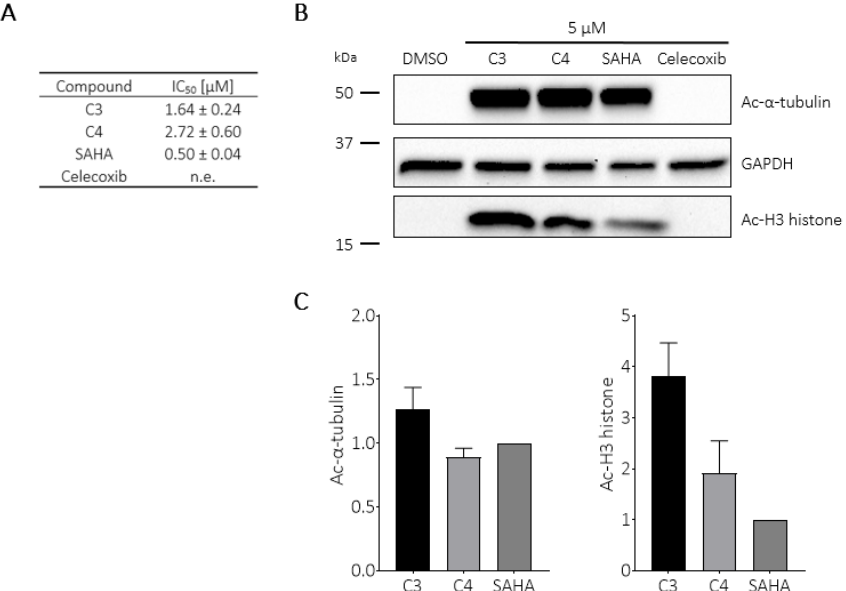
Figure 1. Intracellular target engagement of histone deacetylases by compounds C3 and C4 . ( A ) . Whole-cell HDAC inhibition assays of C3 , C4 , vorinostat, and celecoxib in PC-3 cells; n.e. = no effect up to 25 µM. ( B ) . Representative immunoblot analysis of acetylated α -tubulin and acetylated histone H3. PC-3 cells were incubated for 24 h with C3 , C4 , vorinostat, and celecoxib at the indicated concentration. Afterwards, cell lysates were immunoblotted with anti-acetyl- α -tubulin and acetyl-histone H3 antibodies. GAPDH was used as a loading control. ( C ) . Densitometric analysis of acetylated α -tubulin and acetylated histone H3 of C3 , C4 and vorinostat. Intensity was normalized to GAPDH and depictured in relation to vorinostat.